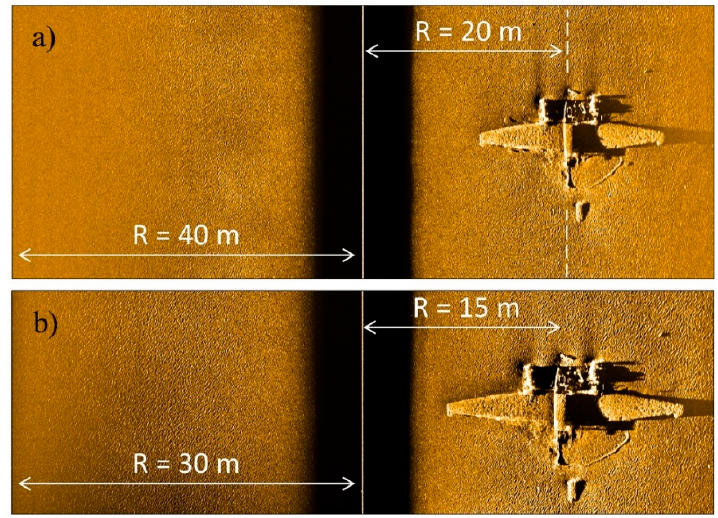
Figure 8. Side scan sonar data of considerable utility and value: ( a ) sonar is flying 20 m from the wreckage, range R = 40 m; ( b ) sonar is flying 15 m from the wreckage, range R = 30 m.